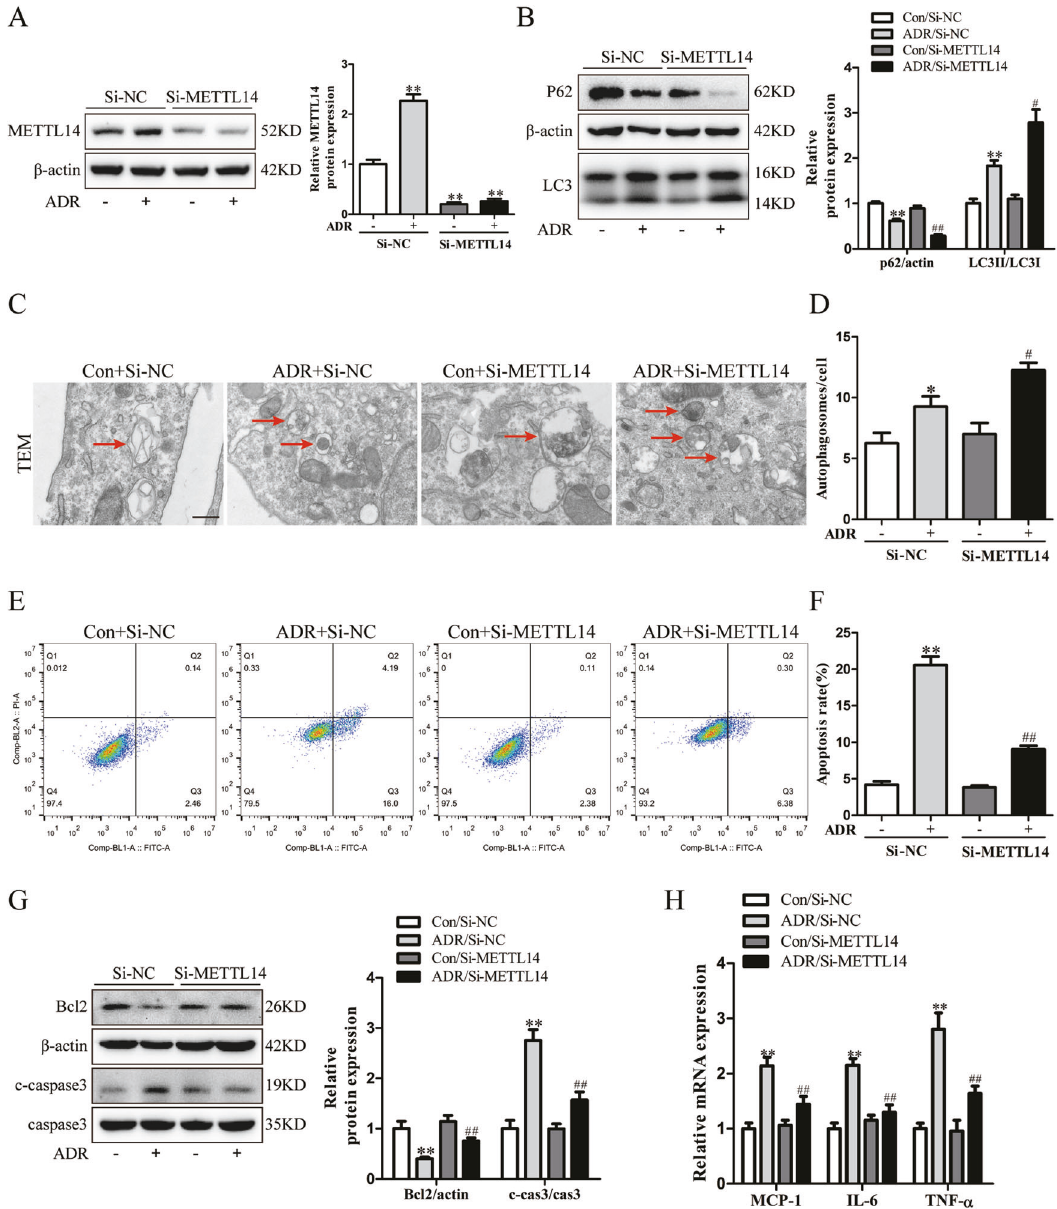
Fig. 5 Knockdown of METTL14 attenuated podocyte injury induced by ADR in vitro. Podocytes transfected with negative SiRNA (SiNC) or METTL14 knockdown SiRNA (SiMETTL14) were subjected to saline or ADR (0.4 μ g/ml). A Western blot analysis of METTL14 protein expression in podocytes with different treatments ( n = 6). B Western blot analysis showing further promotion of autophagy substrate P62 degradation and LC3-I to LC-3II conversion induced by METTL14 knockdown in ADR-treated podocytes ( n = 6). C Representative electronic microscopy images of typical autophagosomes in podocytes with different treatments. The arrows indicate typical autophagosomes with double membranes. Scale bar, 500 nm. D Quantitative analysis of autophagosomes/cell in each group ( n = 4). E Cell apoptosis in podocytes with different treatments. Podocytes in each group were stained with FITC-conjugated Annexin V and PI and examined by fl ow cytometry. Annexin V-positive podocytes were quanti fi ed as apoptotic cells. F Summarized data showing the apoptosis rate of podocytes analyzed by FlowJo software in each group ( n = 6). G Representative immunoblots and quantitative analysis of proapoptotic cleaved caspase-3 and antiapoptotic Bcl2 in the four groups ( n = 6). H The mRNA levels of proin fl ammatory mediators (MCP-1, IL-6 and TNF- α ) in different groups of podocytes ( n = 6). * P < 0.05, ** P < 0.01 vs. Con + SiNC group, # P < 0.05, ## P < 0.01 vs. ADR + SiNC group. Data are presented as mean ±